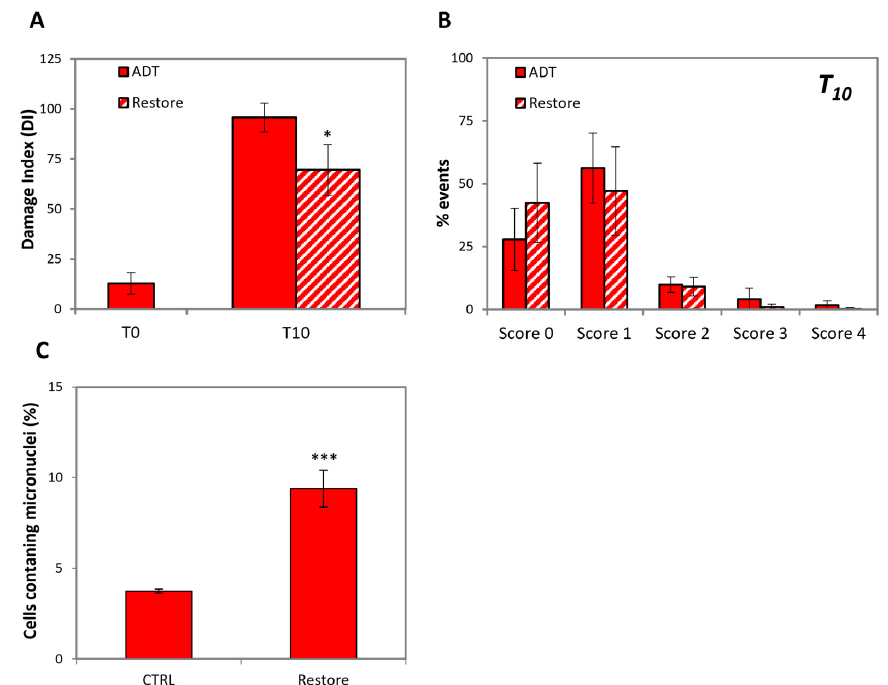
Figure 7. LNCaP cells recovered from ADT are genetically unstable. ( A ) LNCaP cells recovered from a 10-day treatment of ADT only gradually reduced DNA damage. Comet assay of ADT-treated LNCaP before and after androgen restoration: the histogram reports the Damage Index at the indicated time points. ( B ) The histogram shows the scores (from 0 to 4) of DNA damage of ADT-treated LNCaP before and after androgen restoration at the indicated time point. ( C ) LNCaP 48 h after androgen restoration show an increased extent of micronuclei. Statistical significance was calculated via Student’s t -test. * p < 0.05 and *** p < 0.01, with respect to control cells.